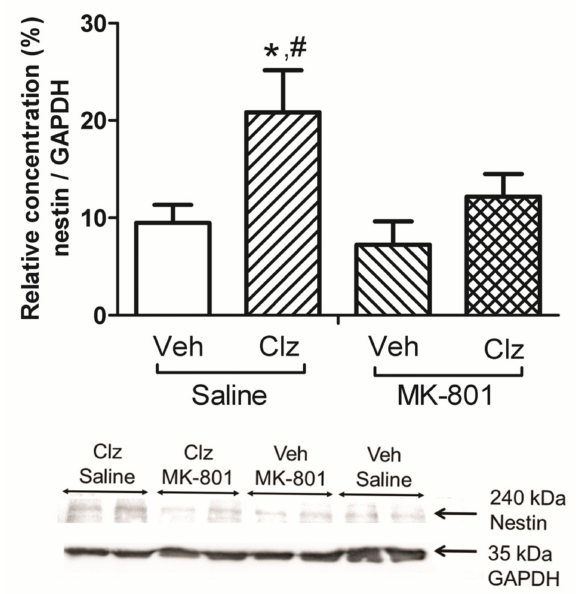
Figure 1. Effects of clozapine 5 mg/kg (Clz), MK-801 0.1 mg/kg, and their combinations on nestin protein concentration in hippocampus of the rats, and representative Western blot images of nestin and GAPDH proteins. Clozapine increases hippocampal nestin concentration, and this effect is blocked by MK-801 co-treatment. Nestin protein concentrations were normalized according to GAPDH loading control (* p < 0.05, compared to Veh + Saline group, # p < 0.05, compared to Veh + MK-801 group, post hoc Tukey’s test; Veh, vehicle, n = 6/group). PPI levels at all three prepulse intensities (73, 76, and 82 dB) changed significantly be- tween the three measurements taken over the two week period (time effect: F(2,48) = 8.244, 5.445, and 9.913; p = 0.0001, 0.007, and 0.0001, respectively). Treatments had significant effects on PPI levels at the 76 and 82 dB prepulse intensities (treatment effect: F(3,24) = 4.228 and 3.301; p = 0.016 and 0.037, respectively). The effects of the treatments interacted with the measurement time only at the 86 dB prepulse intensity level (F(6,48) = 2.901; p = 0.017). Post hoc analyses indicated that MK-801 (0.1 mg/kg) disrupted PPI after two weeks of treatment at the 76 and 82 dB prepulse intensity levels ( p = 0.018 and 0.006; Figure 2B,C, respectively), but not at 73 dB intensity level (Figure 2A). Clozapine (5 mg/kg) reversed the MK-801-induced PPI disruption after two weeks of treatment at the 82 dB prepulse intensity ( p = 0.004; Figure 2C).